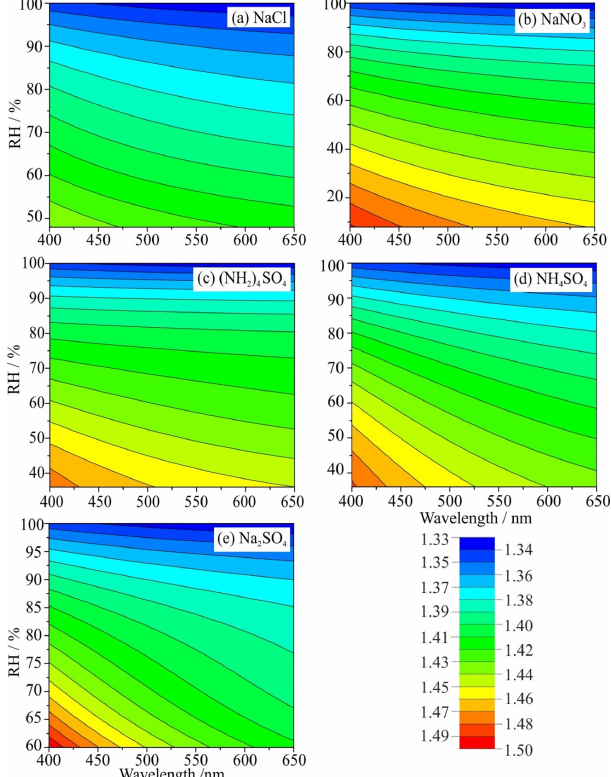
Figure 7. Contour plots representing the parameterisation of RI as a function of both wavelength and RH for aqueous aerosol particles containing the inorganic solutes of